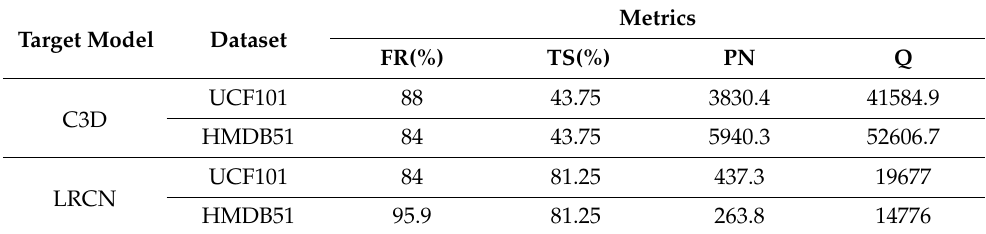
Table 3. Experimental results of black-box attack.